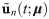
DL-ROM architecture.DL-ROM architecture used during the training phase. In the red box, the DL-ROM to be queried for any new selected couple (t, μ) during the testing phase. The FOM solution u(t; μ) is provided as input to block (A) which outputs u˜n(t;μ). The same parameter instance associated to the FOM, i.e. (t; μ), enters block (B) which provides as output un(t; μ) and the error between the low-dimensional vectors (dashed green box) is accumulated. The intrinsic coordinates un(t; μ) are given as input to block (C) returning the ROM approximation u˜(t;μ). Then the reconstruction error (dashed black box) is computed.